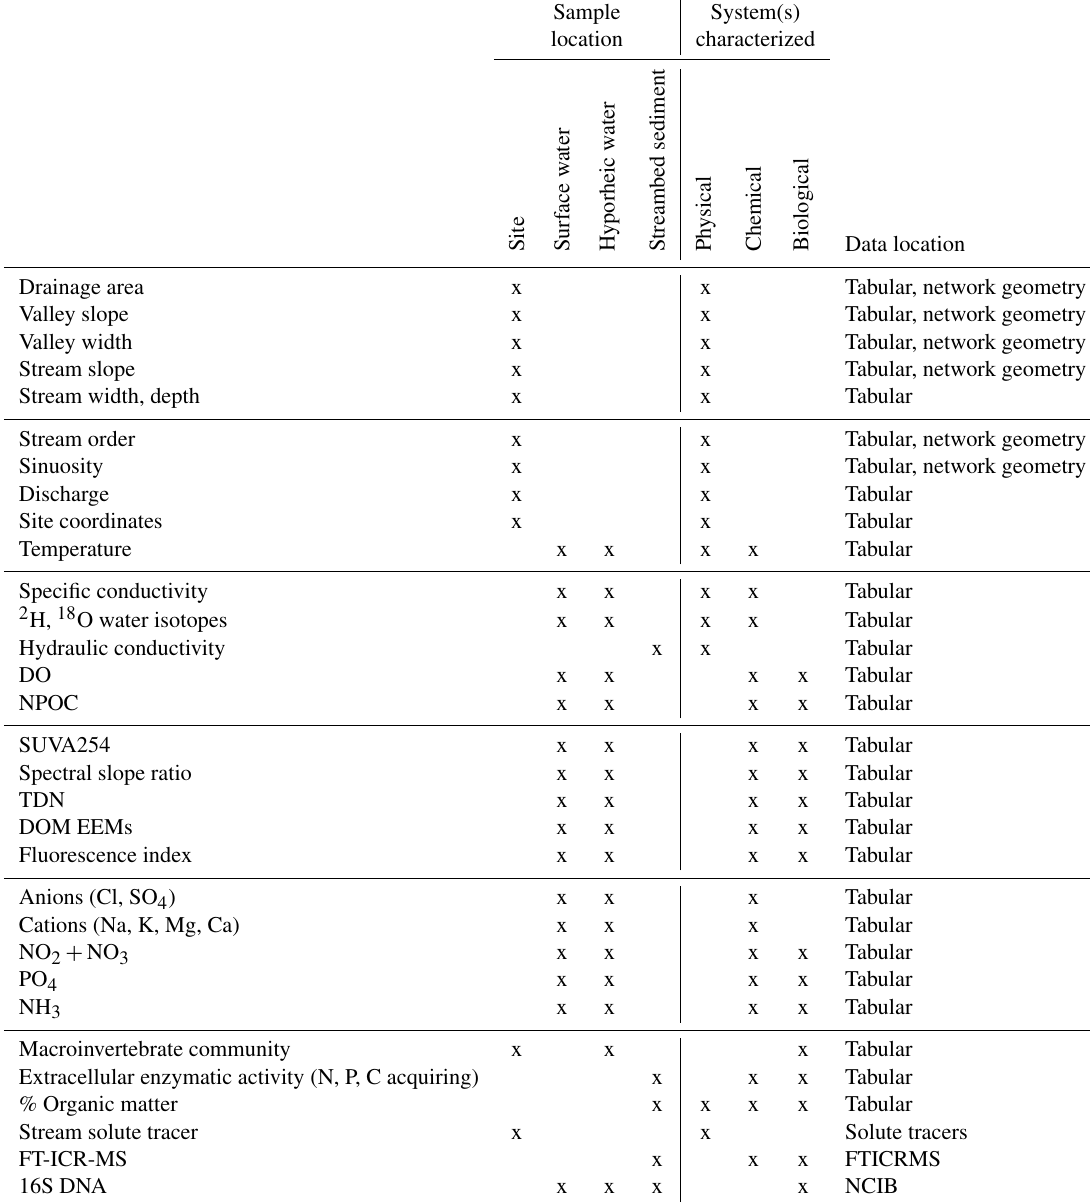
Table 2. Left: Summary of sample collection (site characterization, streambed sediment, stream water, hyporheic water) and analyses in- cluded in this data set. Center: mapping of data types to their characterization of physical, chemical, and/or biological systems (after defini- tions of Ward, 2015). Right: data archival